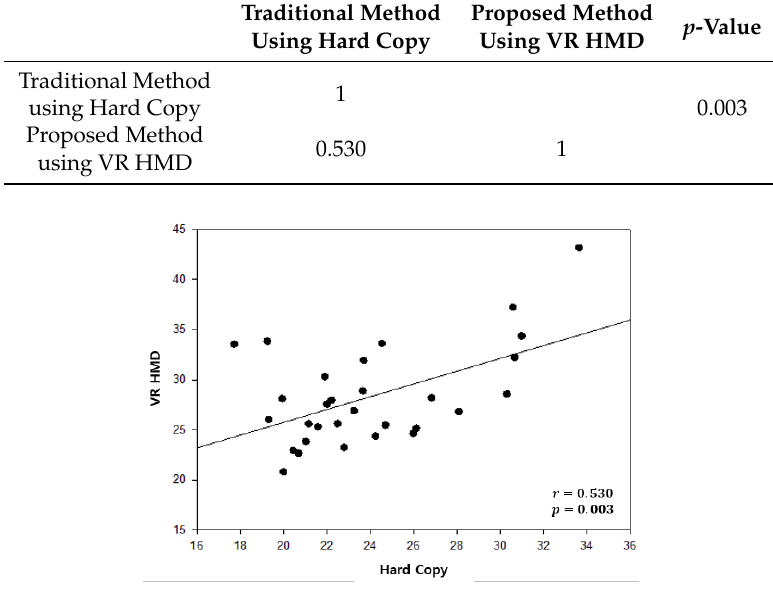
Figure 7. Scatter plot of correlation in the vertical test. Table 7. Correlation between the horizontal tests of the traditional method and the proposed method.